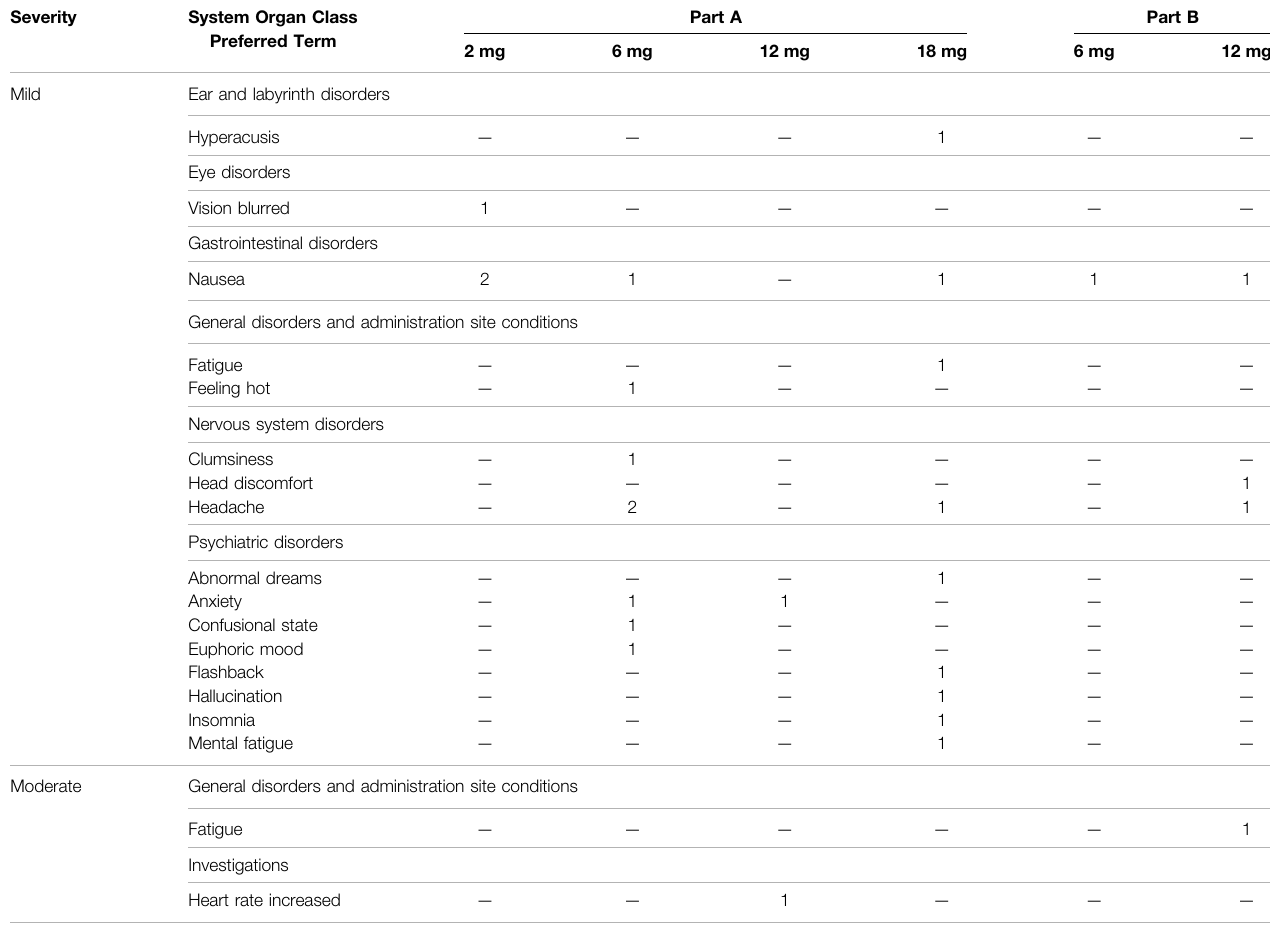
TABLE 1 | Adverse event reported with a relationship to the investigational product as de fi nite, probable, or possible, or where relationship code is missing, by MedDRA System Organ Class and Preferred Term: All Participants by Dose.